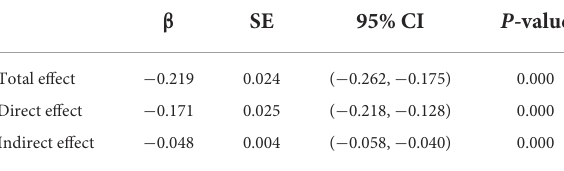
TABLE 6 Results of the mediating effect of exercise frequency on the influence of Internet use on the physical health of the elderly. β SE 95% CI P -value